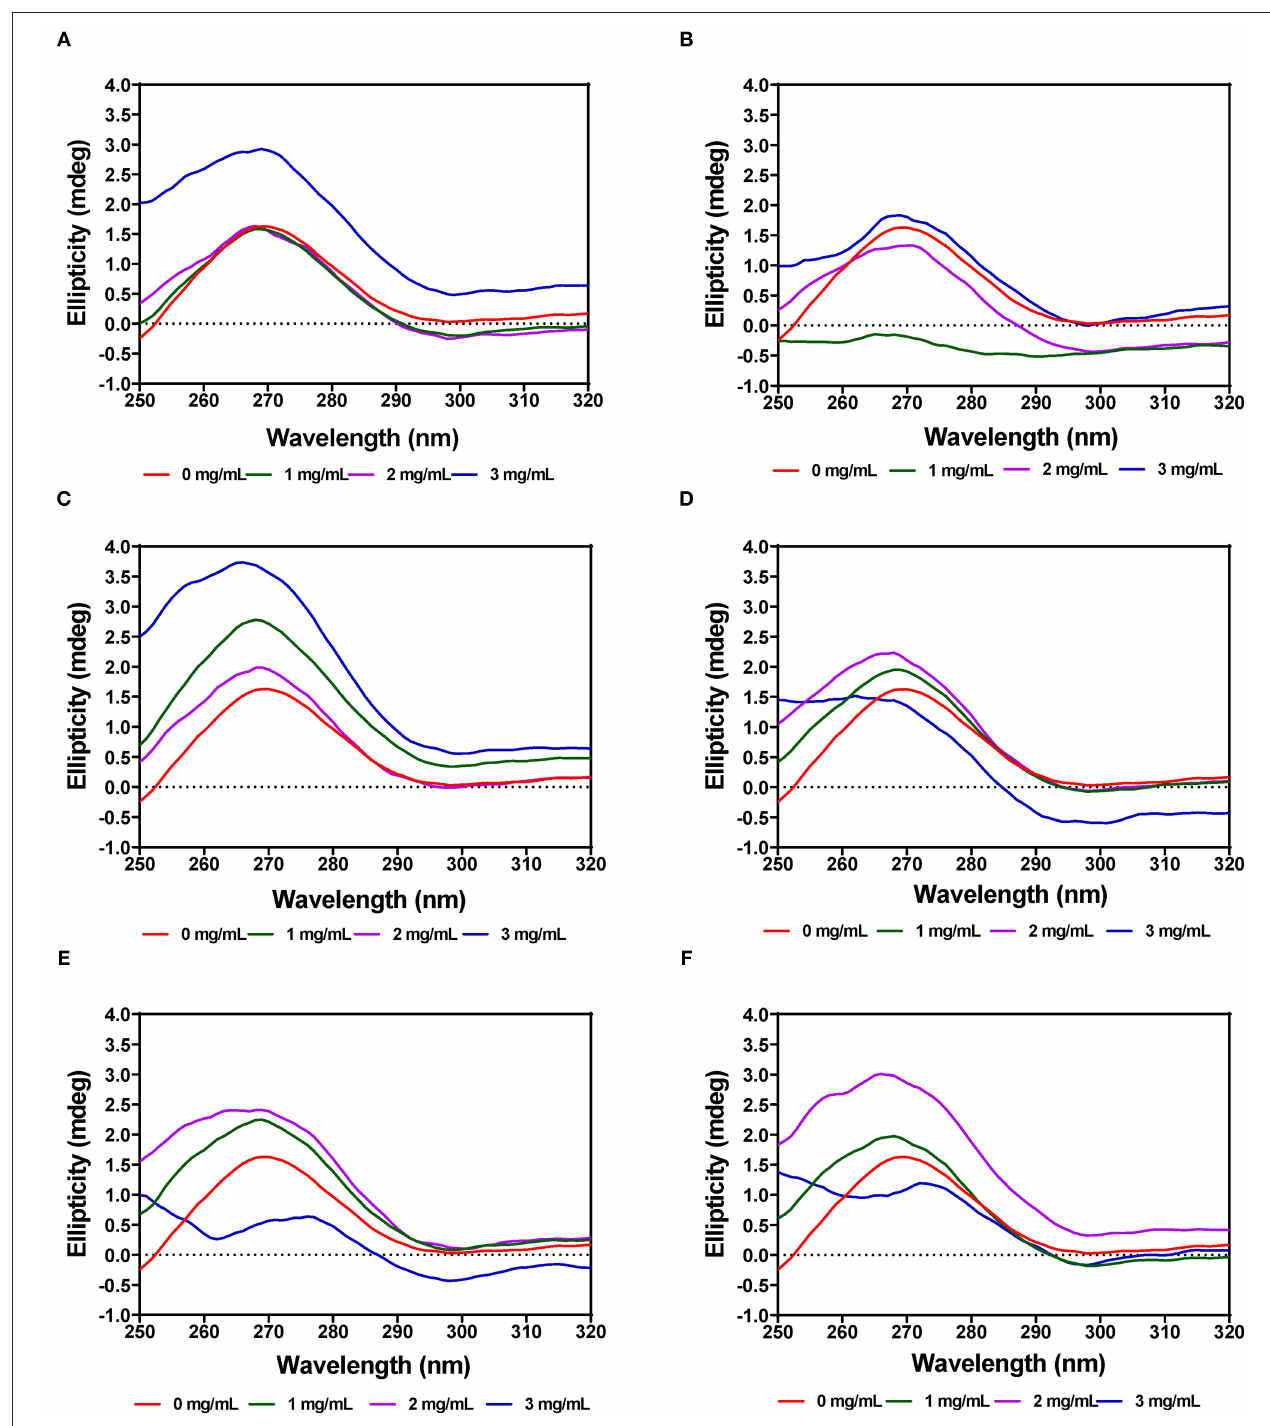
FIGURE 7 | Near-UV CD of α -amylase in the presence of varied concentrations of leaf extracts from: (A) AV-20-T1, (B) AV-20-T2, (C) SM-20-T1, (D) SM-20-T2, (E) TO-20-T1, and (F) TO-20-T2. Plants were produced with nitrogen fertilizer (20 kg N/ha), which was applied at (T1) or after (T2) planting.